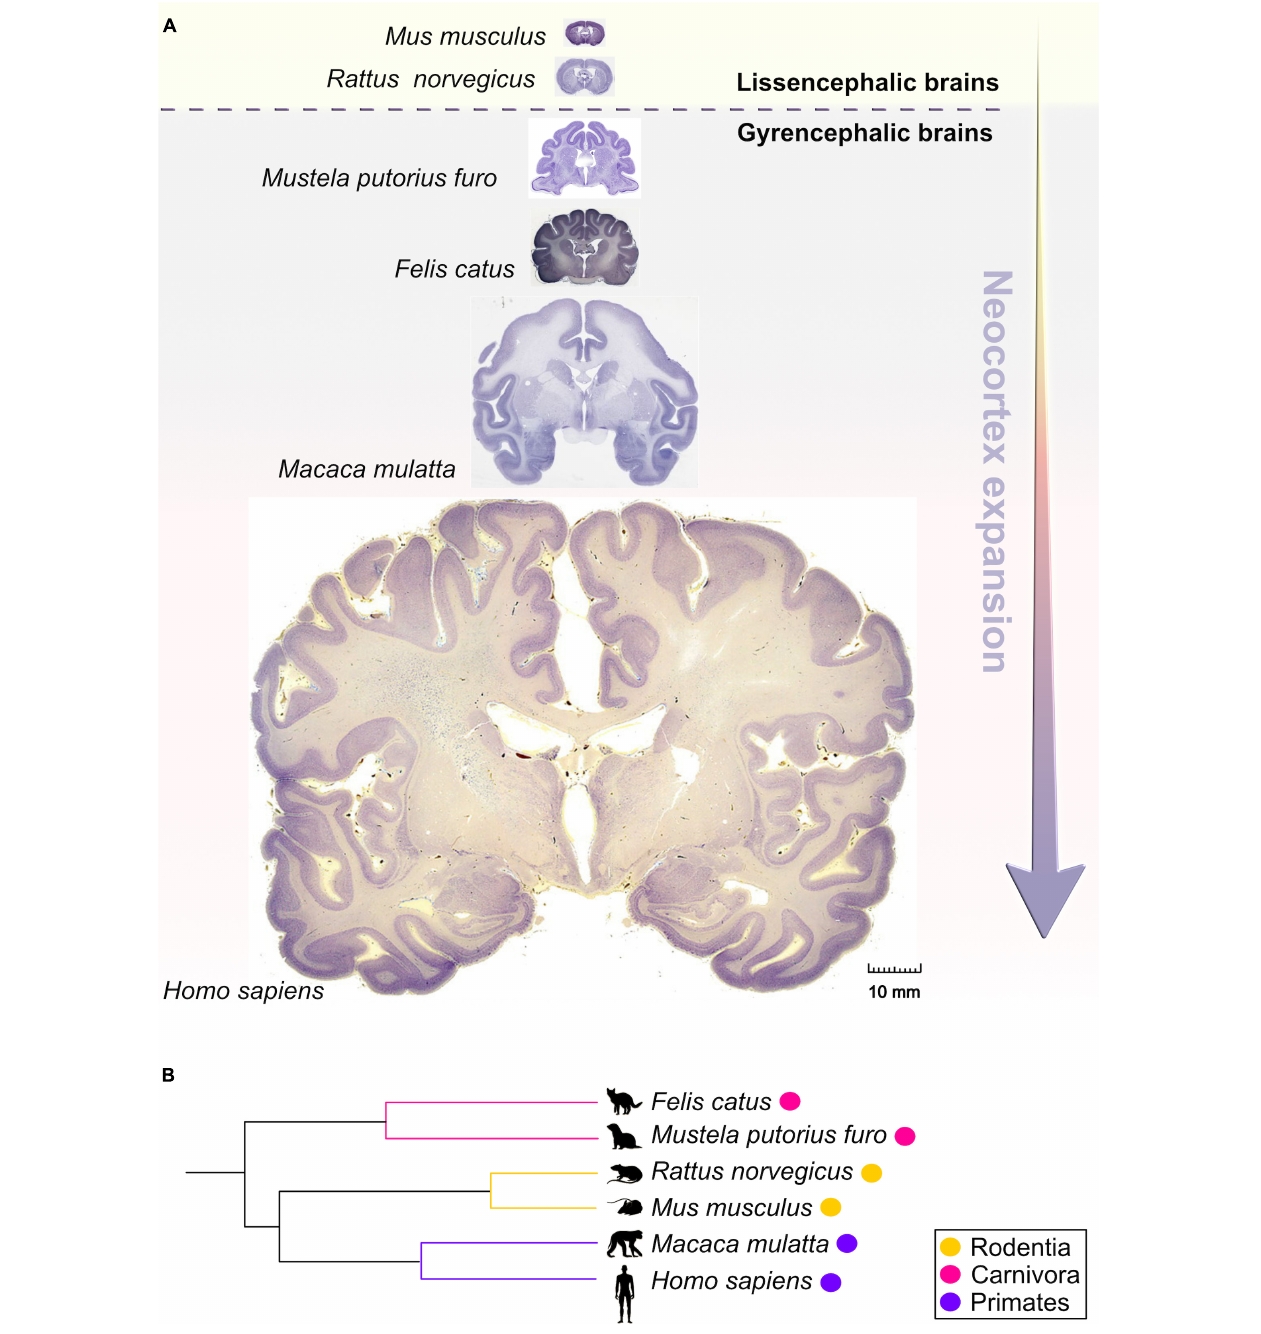
FIGURE 1 | Comparative anatomy of neocortical expansion. (A) Nissl-stained coronal sections at the level of the anterior commissure from adult brains of Mus musculus (mouse), Rattus norvegicus (rat), Mustela putorius furo (ferret), Felis catus (cat), Macaca mulatta (macaque) and Homo sapiens (human). The arrow only illustrates the neocortical development (expansion) but does not encapsulate the evolutionary-scale relationship among these mammalian species. Mammals are grouped into lissencephalic (e.g., Mus musculus , Rattus norvegicus ) and gyrencephalic species (e.g., Mustela putorius furo , Felis catus , Macaca mulatta , and Homo sapiens ) based on cortical folding. Lissencephalic brains have small and smooth neocortices; the gyrencephalic brains have expanded and convoluted neocortices, with considerable variation of gyrification within and between mammalian orders. The images are scaled according to the human brain to demonstrate the notable differences in brain size and patterning of surface convolutions that have evolved from ferrets to humans (scale bar: 10 mm). Images of mouse, rat, cat, and rhesus macaque are obtained from BrainMaps next-generation atlas (Mikula et al., 2007), the ferret image was adopted from Radtke-Schuller (2018), and the human image was acquired from Michigan State University Human Brain Atlas (https://brains.anatomy.msu.edu/). (B) A species phylogenetic tree obtained using examples from (A) . This simplified representation shows that the ferrets and cats (gyrencephalic cortex) are more evolutionarily distant from humans than mouse and rats (lissencephalic